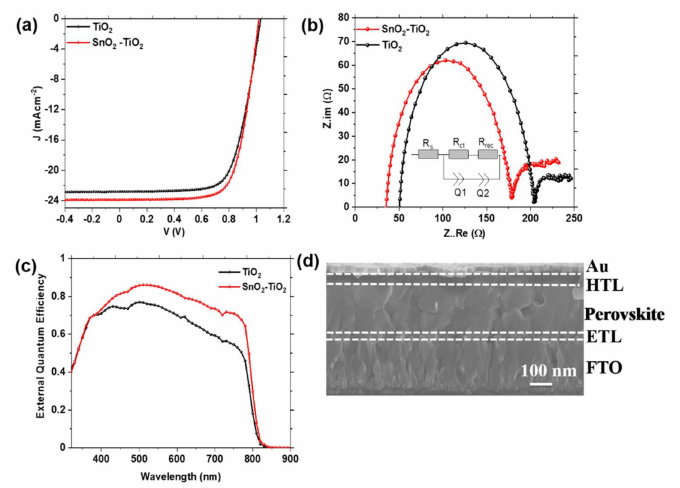
Figure 7. ( a ) J-V curves; ( b ) Nyquist curves and ( c ) EQE curves of the control and the best performing PSC devices ( d ) Cross-sectional image of the fabricated planar